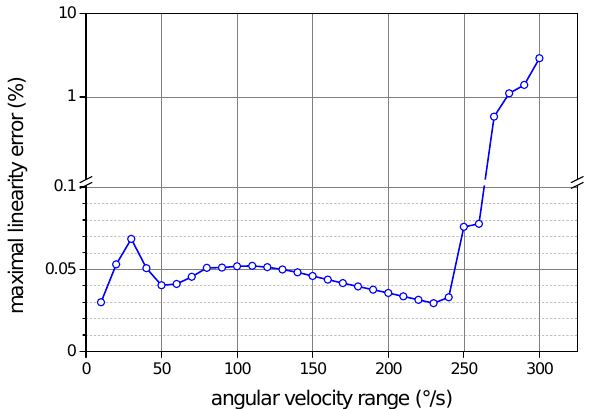
Figure 10. The deviation of the measured output characteristics of the open-loop and closed-loop I-FOG from their ideal linear approximations. The output voltage and the corresponding angular velocity errors are scaled by the vertical axes. A detailed view of the small angular velocities is shown in the inset.